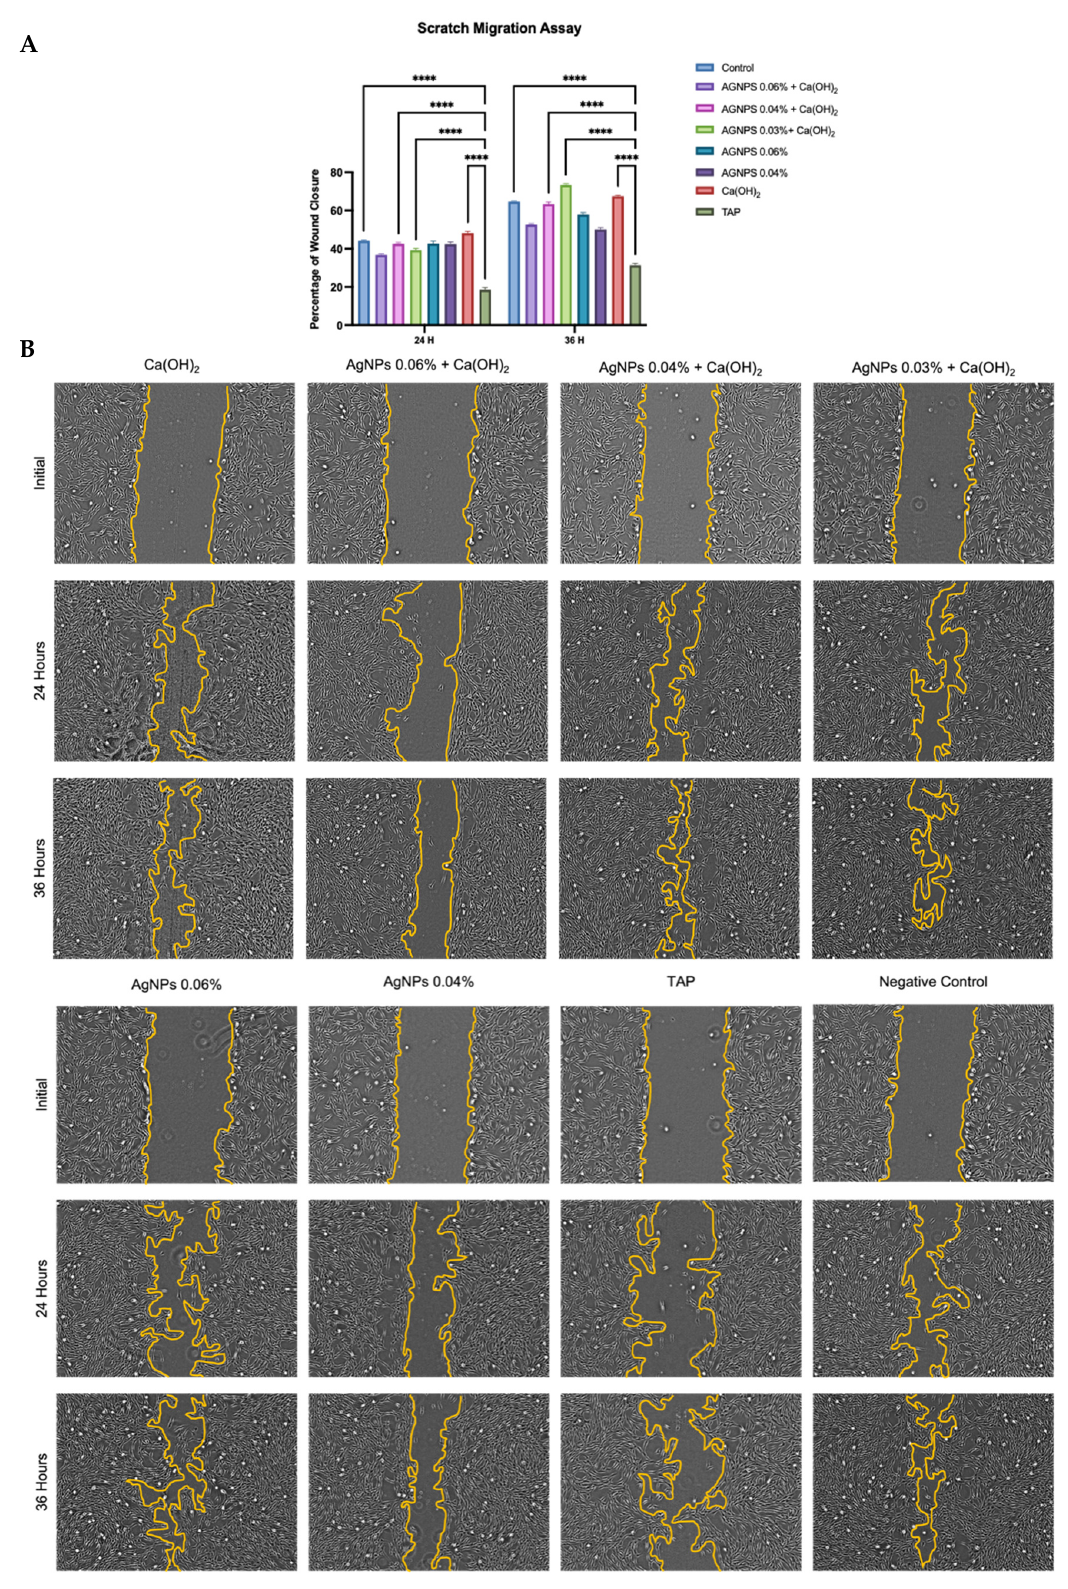
Figure 8. Results of the scratch migration assay at 0, 24, and 36 h. Percentages of wound closure are shown in ( A ), and representative images are shown in ( B ). Asterisks (****) indicate statistical significance ( p < 0.05). Scale bar: 50 µm [Ca(OH) 2 : Calcium hydroxide, AgNPs: Silver nanoparticles, TAP: Triple antibiotic paste] .